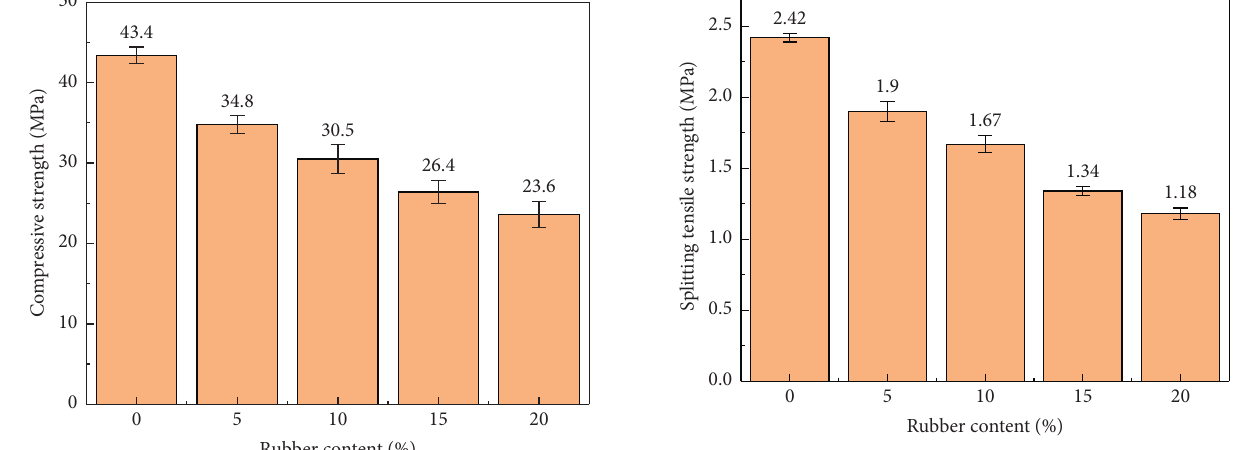
Figure 6: 28-day splitting tensile strength of fiber concrete with different rubber